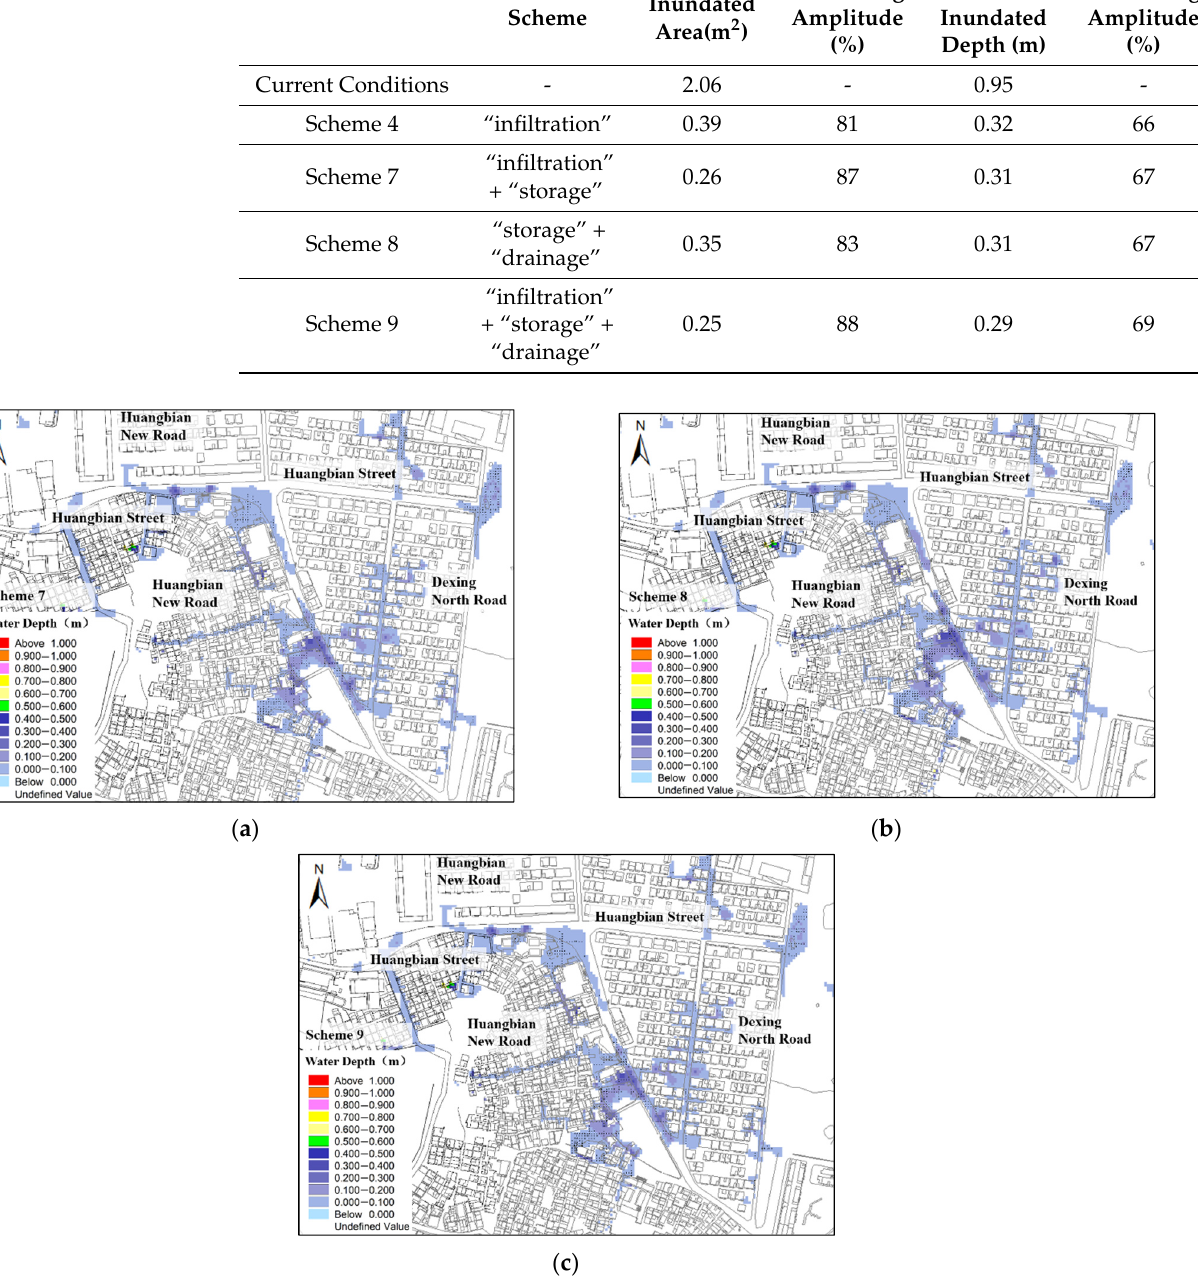
Figure 7. Simulation results of comprehensive schemes under designed rainfall conditions. ( a ) Scheme 7; ( b ) Scheme 8; ( c ) Scheme